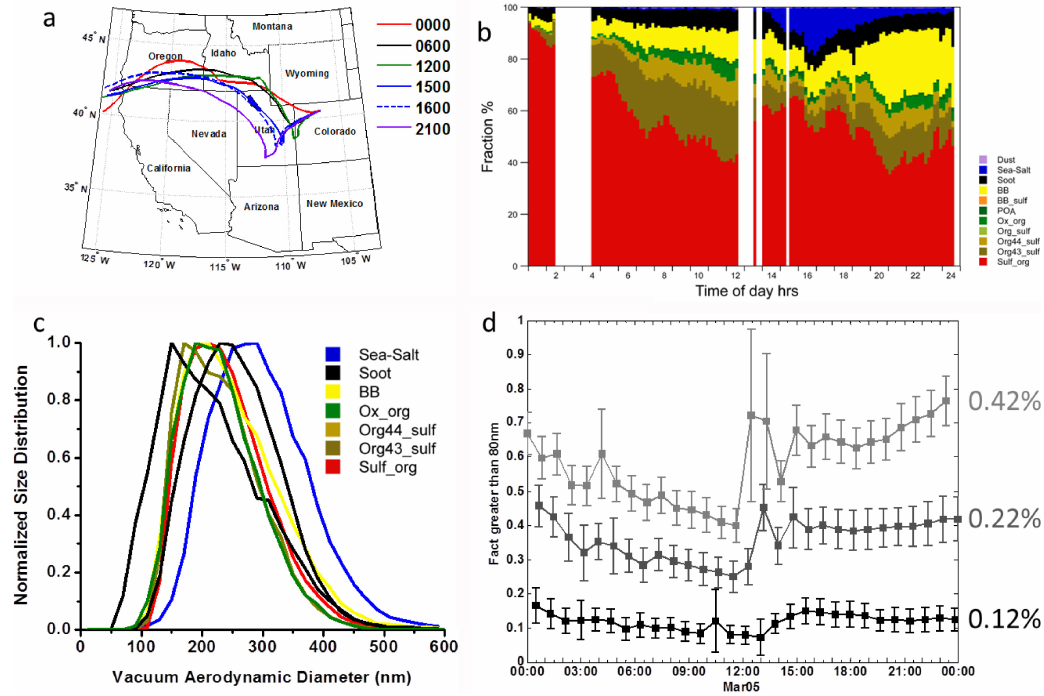
Fig. 3. Calculated back trajectories, aerosol compositions, size distributions, and activated fraction of particles greater than 80nm for 5 March 2011. (a) back trajectories at a variety of times throughout the day on 5 March, showing transport of sea salt particles over Salt Lake. (b) time evolution of composition throughout the day, as measured by SPLAT. (c) Composition-resolved size distributions. Colors are the same as the composition plot (b) . (d) Activated fraction of particles greater than 80nm as a function of measured CCN supersaturation and time of day on 5